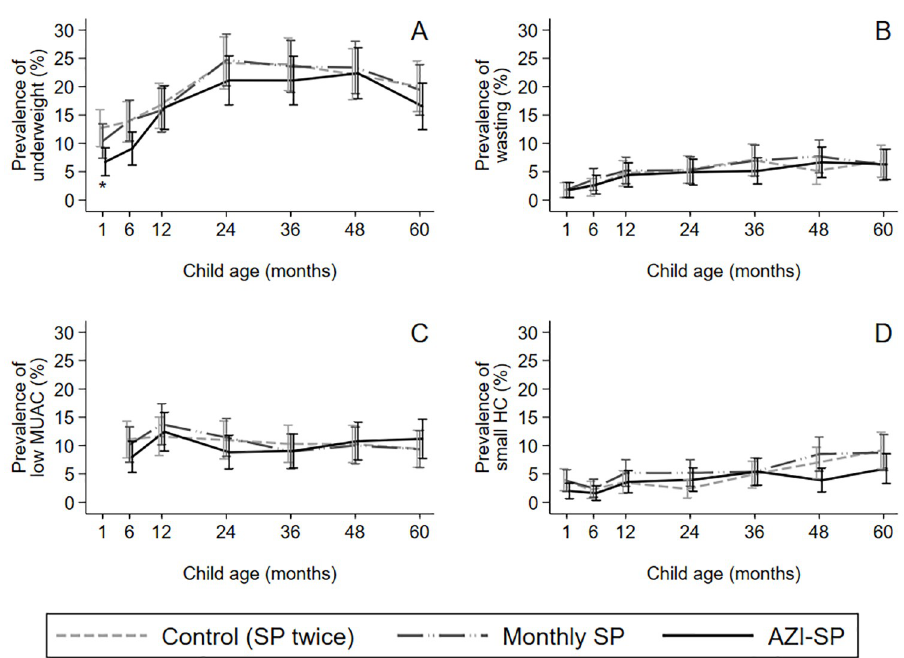
Fig 4. Prevalence of underweight, wasting, low mid-upper arm circumference, and small head circumference by intervention group. At one, six, 12, 24, 36, 48 and 60 months of age. (A) Underweight defined as weight-for-age Z- score < -2. (B) Wasting defined as weight-for-height Z-score (WHZ) < -2. (C) Low mid-upper arm circumference (MUAC) defined as MUAC-for-age Z-score < -2. (D) Small head circumference (HC) defined as HC-for-age Z-score < -2. SP = sulfadoxine-pyrimethamine; AZI-SP = intervention group with monthly SP and two doses of azithromycin. � denotes P < 0.05 between AZI-SP and the control group.